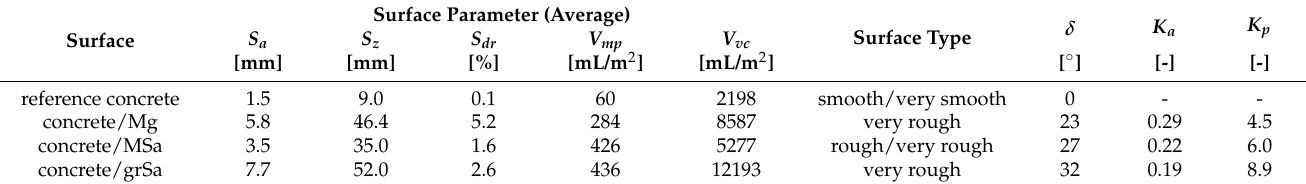
Table 4. Pressure coefficient values K a , K p for tested surfaces according to Equations (7) and (10). Surface Parameter Surface